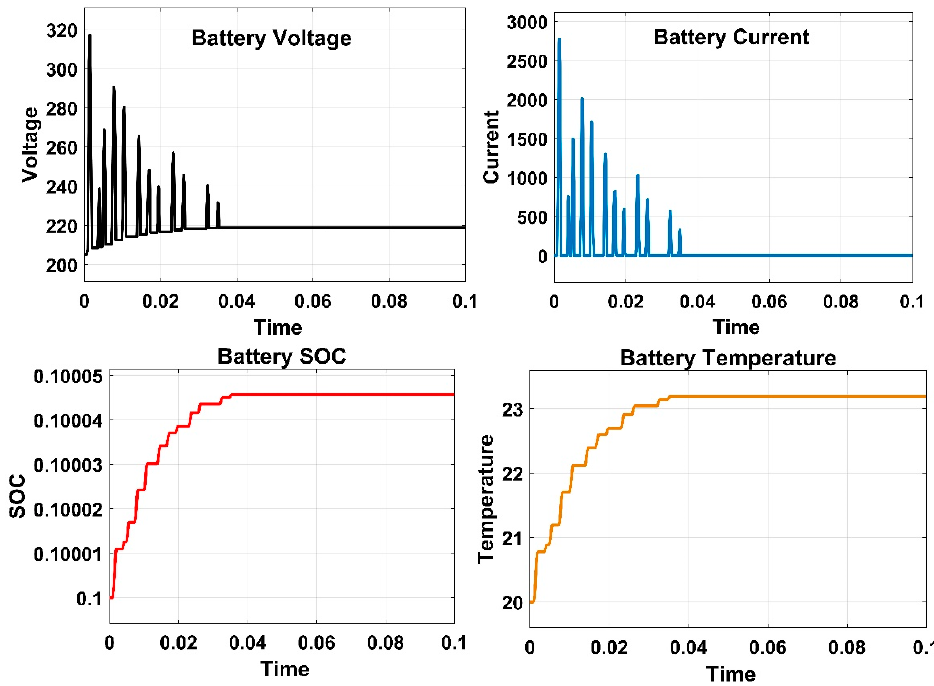
Figure 3. Battery current, voltage, SOC, and temperature in case of fast charging.